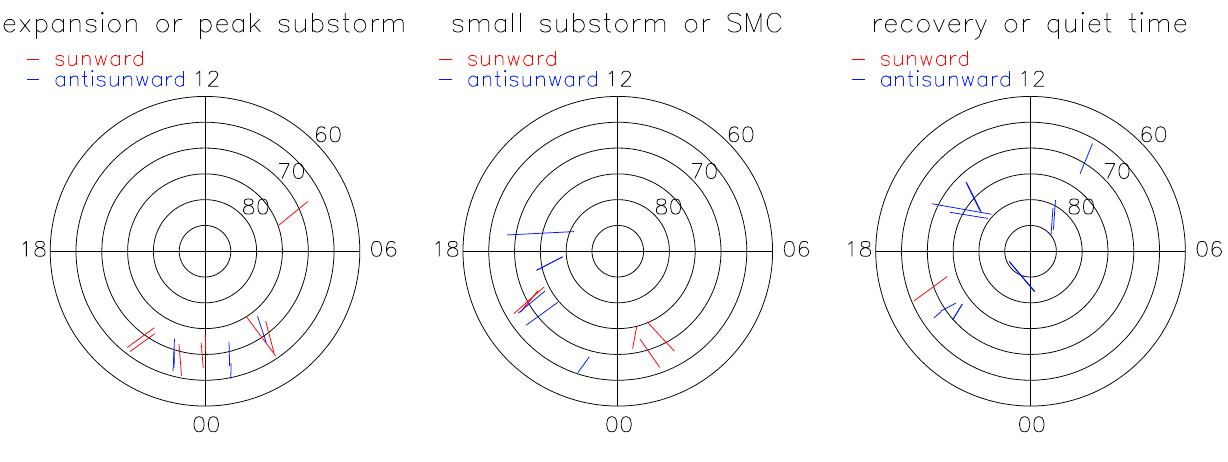
Fig. 4. The distribution of intense electric field events sorted according to different substorm phases: The left plot shows all poleward oval crossings where an intense E-field event appears during substorm expansion or peak substorm phase. The middle plot contains all events during small substorms or SMC events. The right plot contains all substorm recovery and quiet time cases. The red and blue colors correspond to an average plasma flow direction in sunward and in anti-sunward direction, respectively. Table 1. IMF B z conditions during the hour before the E-peak occurrence. IMF B z (GSM) southturn southward northturn northward at E-peak IMF at E-peak IMF Substorm expansion events 0 11 1 1 Small substorms / SMC events 2 5 0 1 Substorm recovery events 2